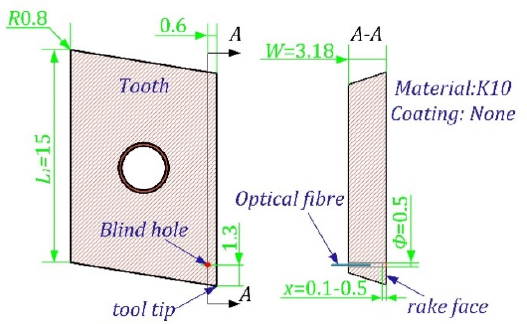
Figure 7. Details of the insert and the blind hole to install optical fiber (Sato et al. [35]). Table 2. Cutting parameters adopted in Sato et al. [35].